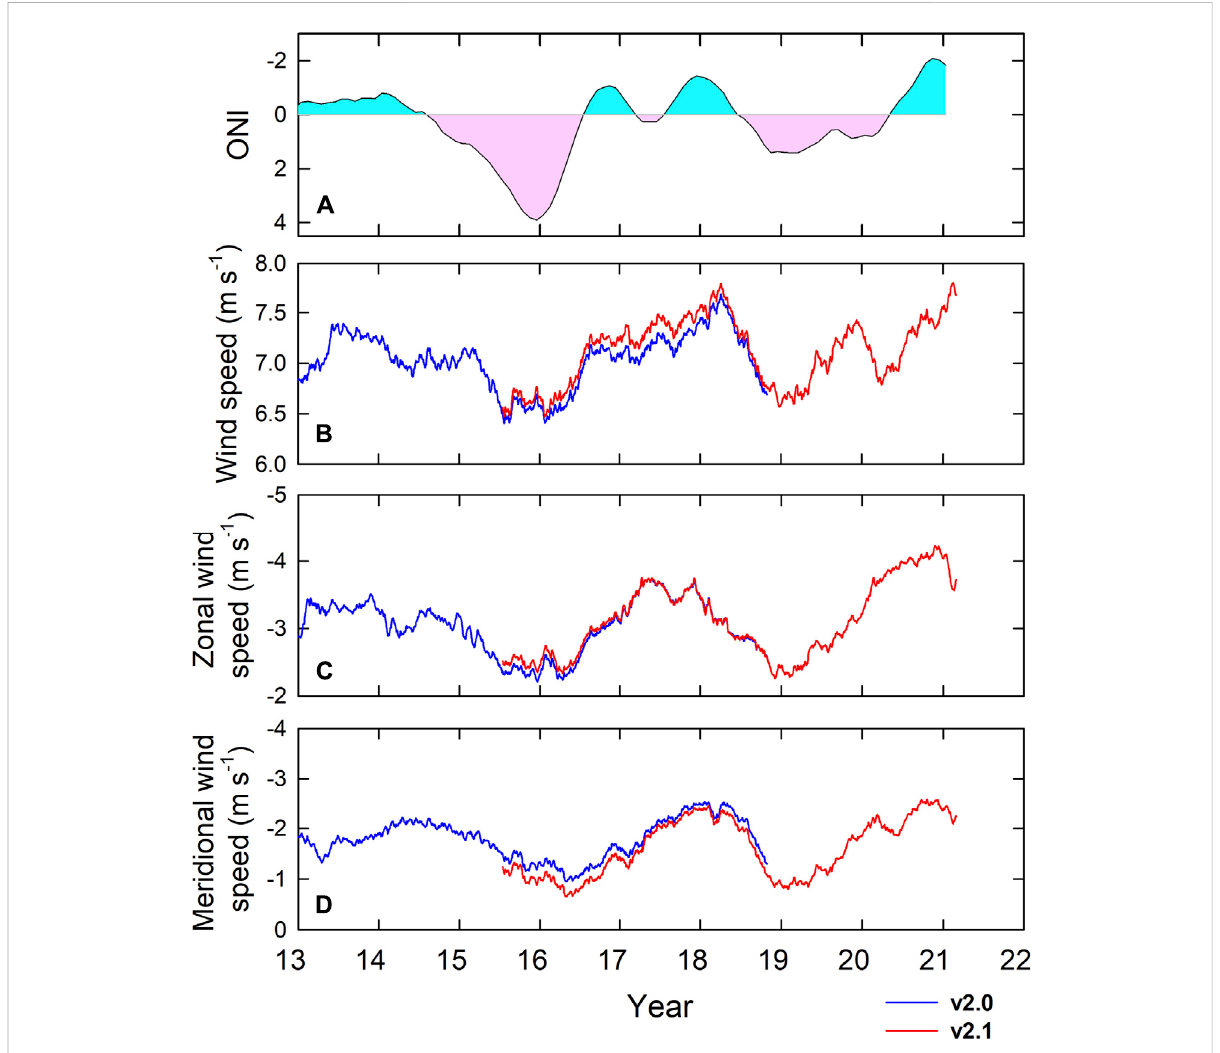
FIGURE 8 Time-series of (A) ONI (pink and light blue areas refer to positive and negative values, respectively) and yearly-smoothed satellite-derived (B) wind speed, (C) zonal wind speed, and (D) meridional wind speed at SEATS between 2013 and 2021. The blue and red lines show the v2.0 and v2.1 data,